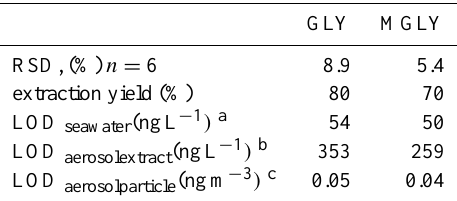
Table 2. Validation data for GLY and MGLY; relative standard de- viation (RSD), extraction yields and limits of detection (LOD).